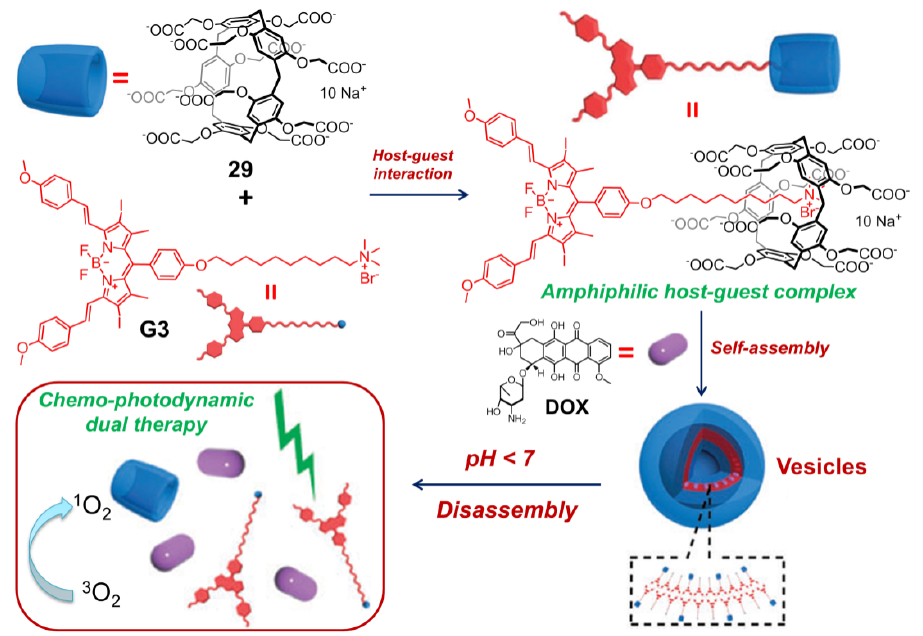
Figure 20. pH-sesponsive supramolecular vesicles assembled by water-soluble pillar[5]arene 29 and a BODIPY derivative G3 for chemo-photodynamic dual therapy. Reproduced with permission from Reference [104]. Copyright 2015 Royal Society of Chemistry.